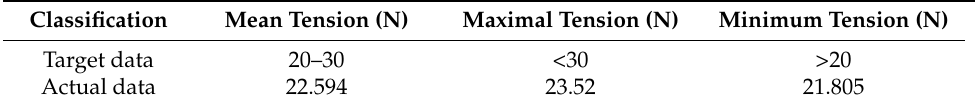
Table 6. Statistical analysis of mask-fastening tensions.